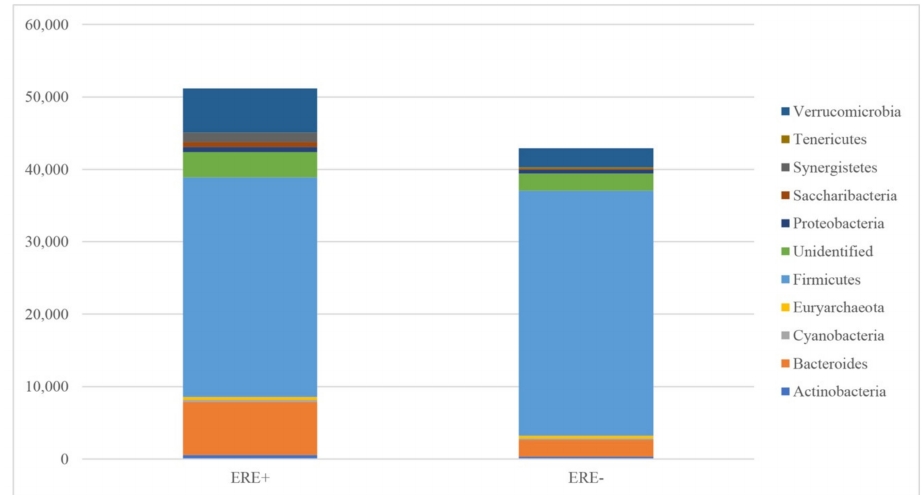
Figure 2. The abundance of bacterial genera in cecal samples of healthy and ERE rabbits. ERE + : Rabbits positive for epizootic enteropathy. ERE − : Healthy rabbits.